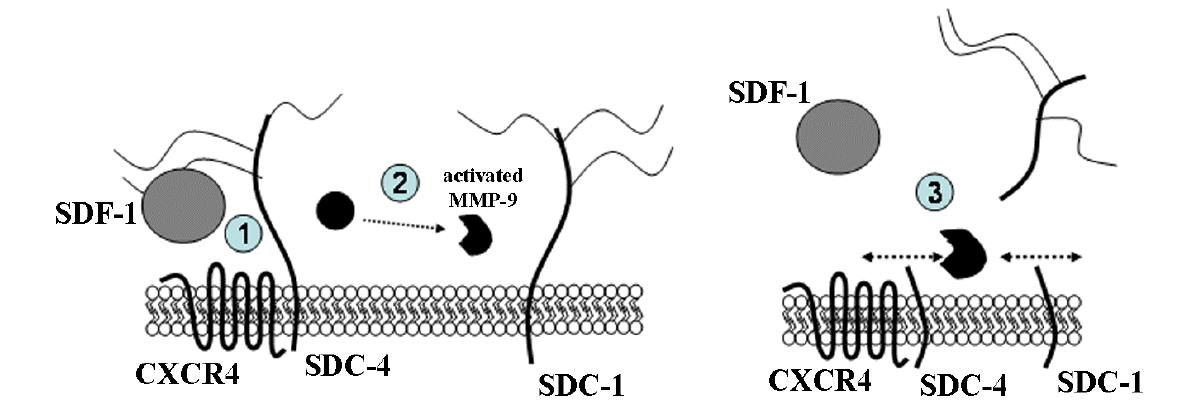
FIGURE 1. The shedding of SDC-4 and SDC-1 from HeLa cells and human primary macrophages is accelerated by SDF-1/CXCL12 and mediated by MMP-9. (1) SDF-1 binding to SDC-4 facilitates its presentation to CXCR4; (2) SDF-1 activates MMP-9, which is involved in syndecan shedding; (3) decreased membrane expression of syndecans down-regulates SDF-1 binding to the